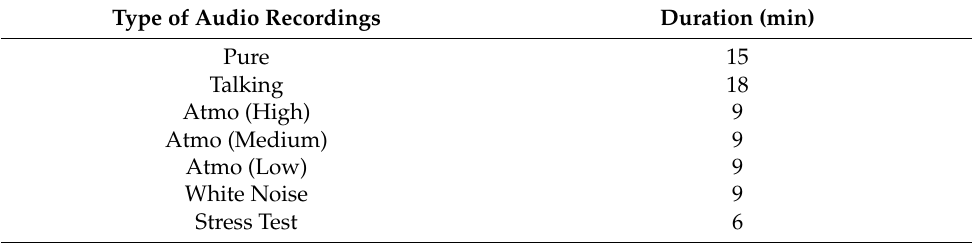
Table 2. Audio recordings from the IDMT-ISA-ELECTRIC-ENGINE